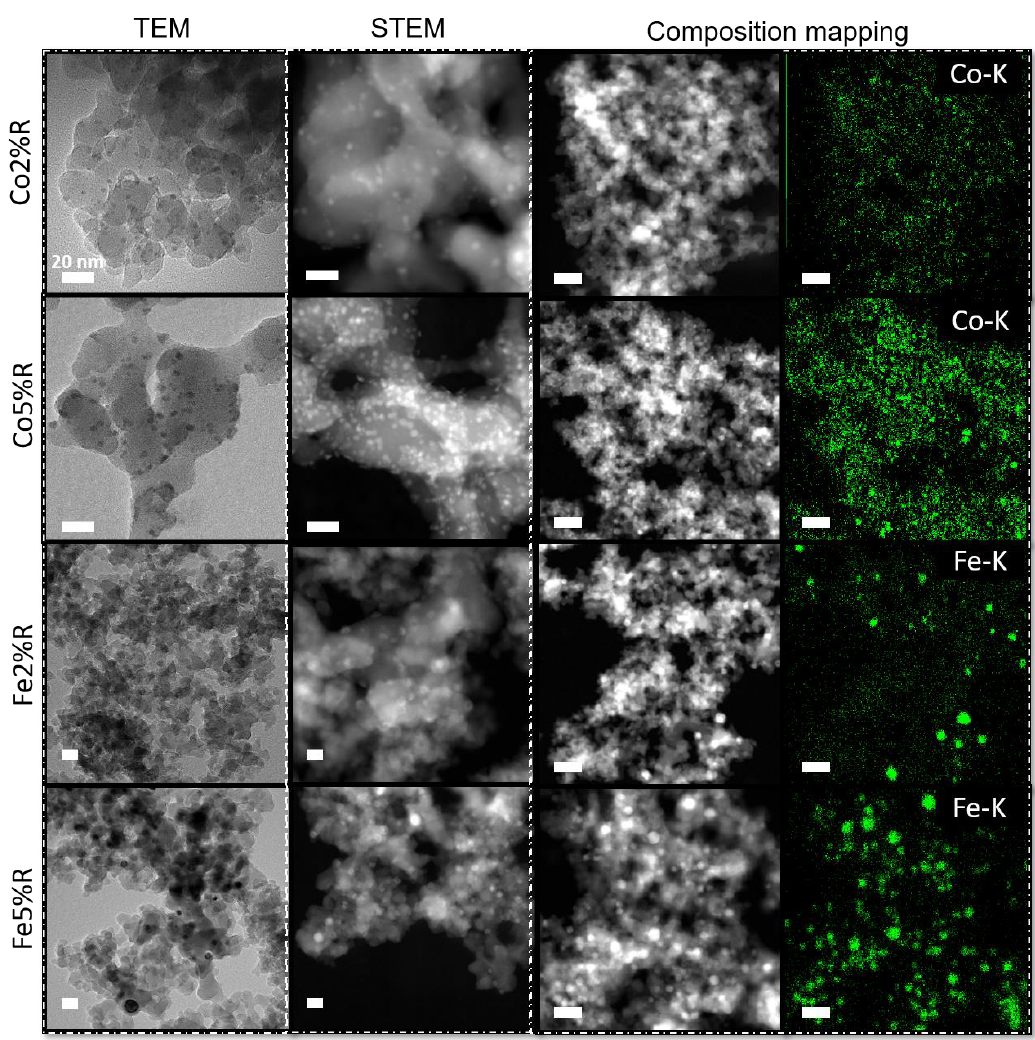
Figure 4. TEM/STEM micrographs and composition mapping from Co and Fe catalyst (2% and 5%) on SiO 2 surface after reduction. Inset scale bar: 20 nm.